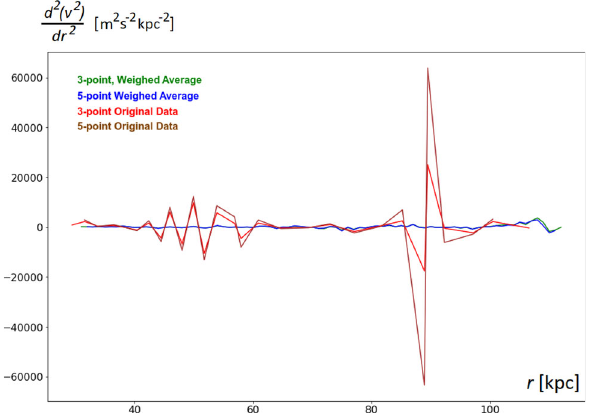
Fig. 2 Second radial derivatives of orbital speed squared d 2 v 2 lated using the three-point scheme for the calculation of derivatives (19) and the five-point scheme for the calculation of derivatives (20), with smoothing (referred to as weighted average) and without smoothing (referred to as original data)